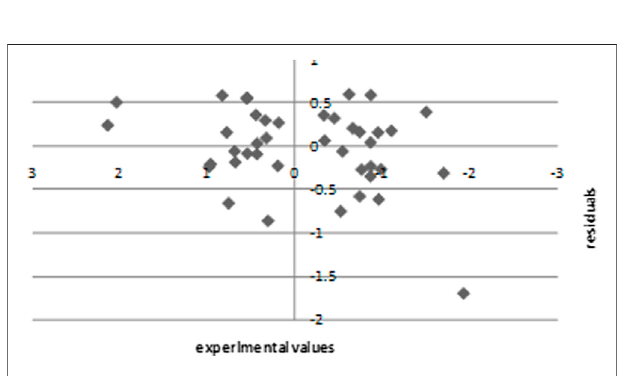
FIGURE6| ExperimentalpIC50versusresidualplotininternalvalidation.